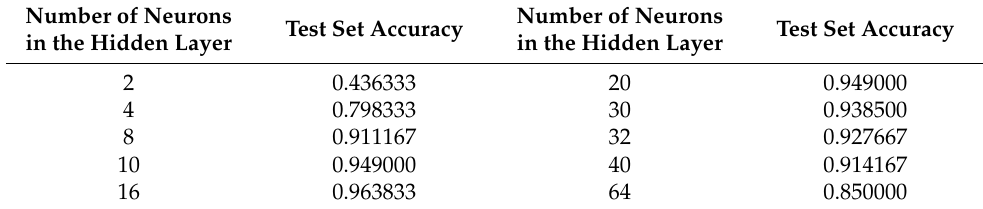
Table 4. Tests for Determining Neurons in the Hidden Layer.